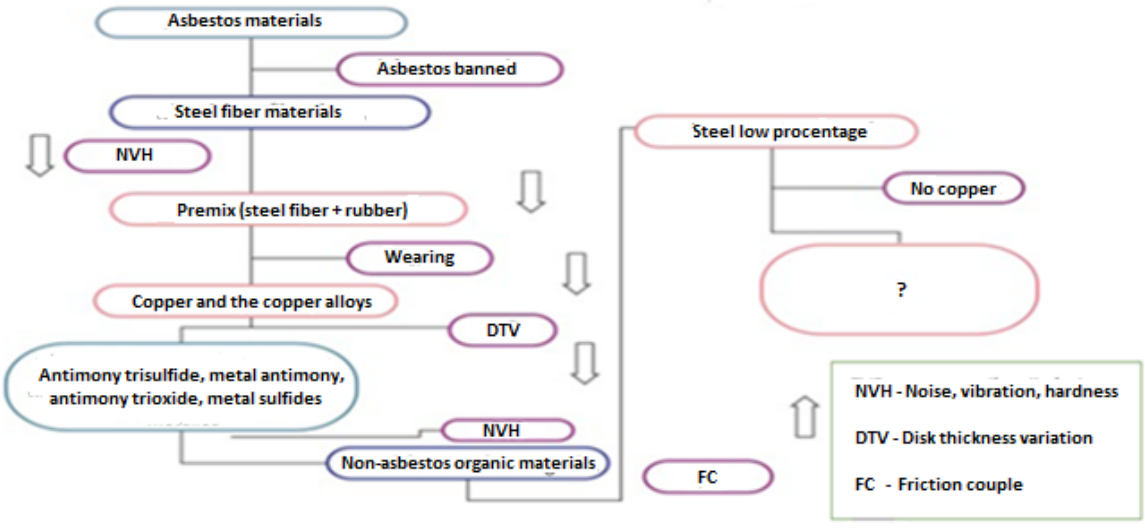
Figure 2. Presentation of the friction material formulas evolution from the last two decades (reprinted/adapted with permission from ref. [21]. 2022, Elsevier). Table 2. Lubricants and metals percentage in non-organic asbestos materials (reprinted/adapted with permission from ref. [21]. 2022, Elsevier).